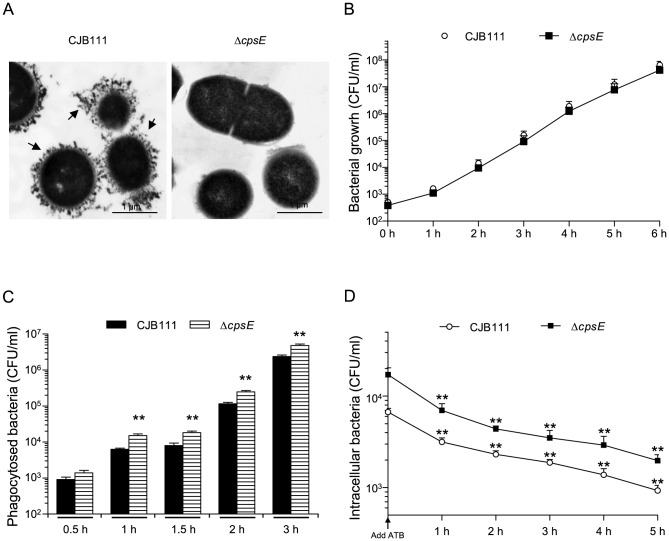
Phagocytosis by and intracellular survival within DCs of type V GBS: role of bacterial capsular polysaccharide.(A) Transmission electron micrographs of GBS strains labeled with polycationic ferritin show GBS wild-type strain CJB111 with a thick capsule (indicated by arrows) whereas no capsular material is observed in ΔcpsE mutant strain. (B) Growth curves of wild-type GBS strain CJB111 and ΔcpsE mutant strain. (C) Wild-type type V GBS strain CJB111 or the ΔcpsE non-encapsulated mutant (106 CFU/ml, initial MOI:1) were incubated with C57BL/6J-derived bmDCs for different time periods. Internalized bacteria were enumerated by quantitative plating after 1 h of antibiotic treatment to kill extracellular bacteria. ** P<0.01, indicates statistically significant differences between the wild-type strain CJB111 and the non-encapsulated mutant, n = 5. (D) For intracellular survival assays, bmDCs were infected with GBS strains (MOI:1) and phagocytosis was left to proceed for 60 min. Antibiotics (ATB) were then added for 1 h (defined as time 0). This initial antibiotic-treatment was extended up to 5 h and cells lysed to quantify intracellular bacteria by viable plate counting. ** P<0.01, indicates incubation times for which significantly differences in the numbers of recovered intracellular bacteria were observed compared to time 0, n = 8. All results are expressed as CFU recovered bacteria per ml (means ± SEM). It should be noted that initial MOI was the same for all conditions and bacterial growth rate in the culture medium was identical for both strains.